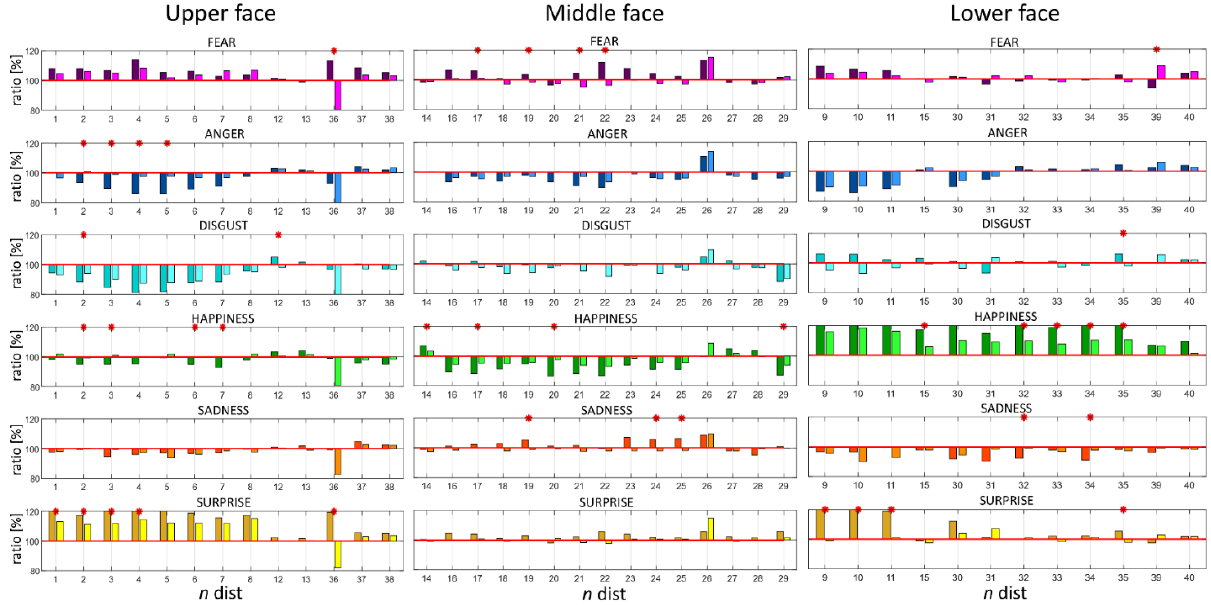
Figure 4. Values of normalized distances per each emotion in the three face regions: upper, middle, and lower. The x-axis represents the distance number, y-axis the values of ratios expressed in % from the neutral expression. Darker colors correspond to the HC population whereas lighter ones to PD. Red * highlights statistically significant differences at the 0.05 confidence level. Table 2. Statistically significant ratios obtained per each emotion and face region. ns = non- significant.